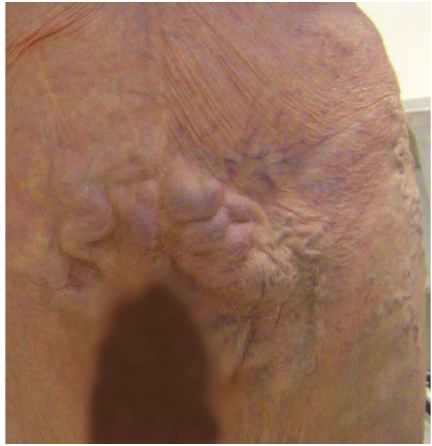
Figure 2: Large subcutaneous collateral veins.